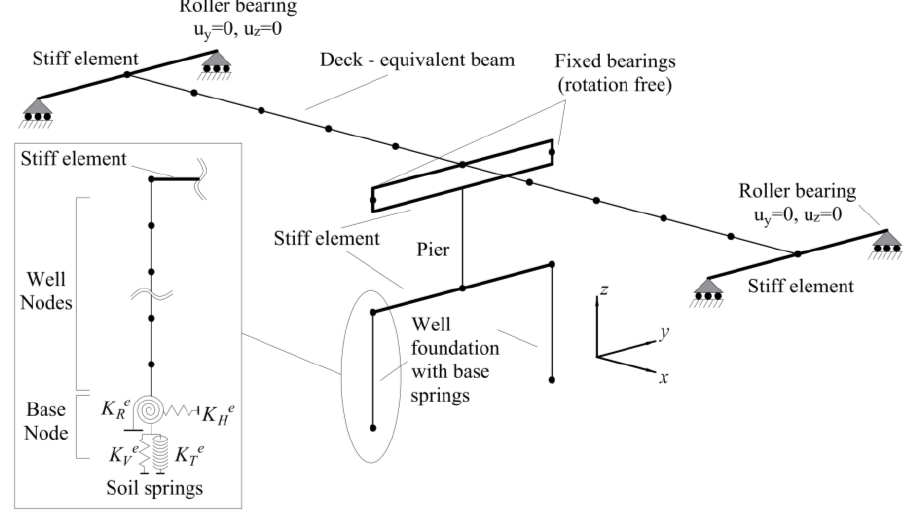
Figure 5. Scheme of the numerical model of the case-study bridge.